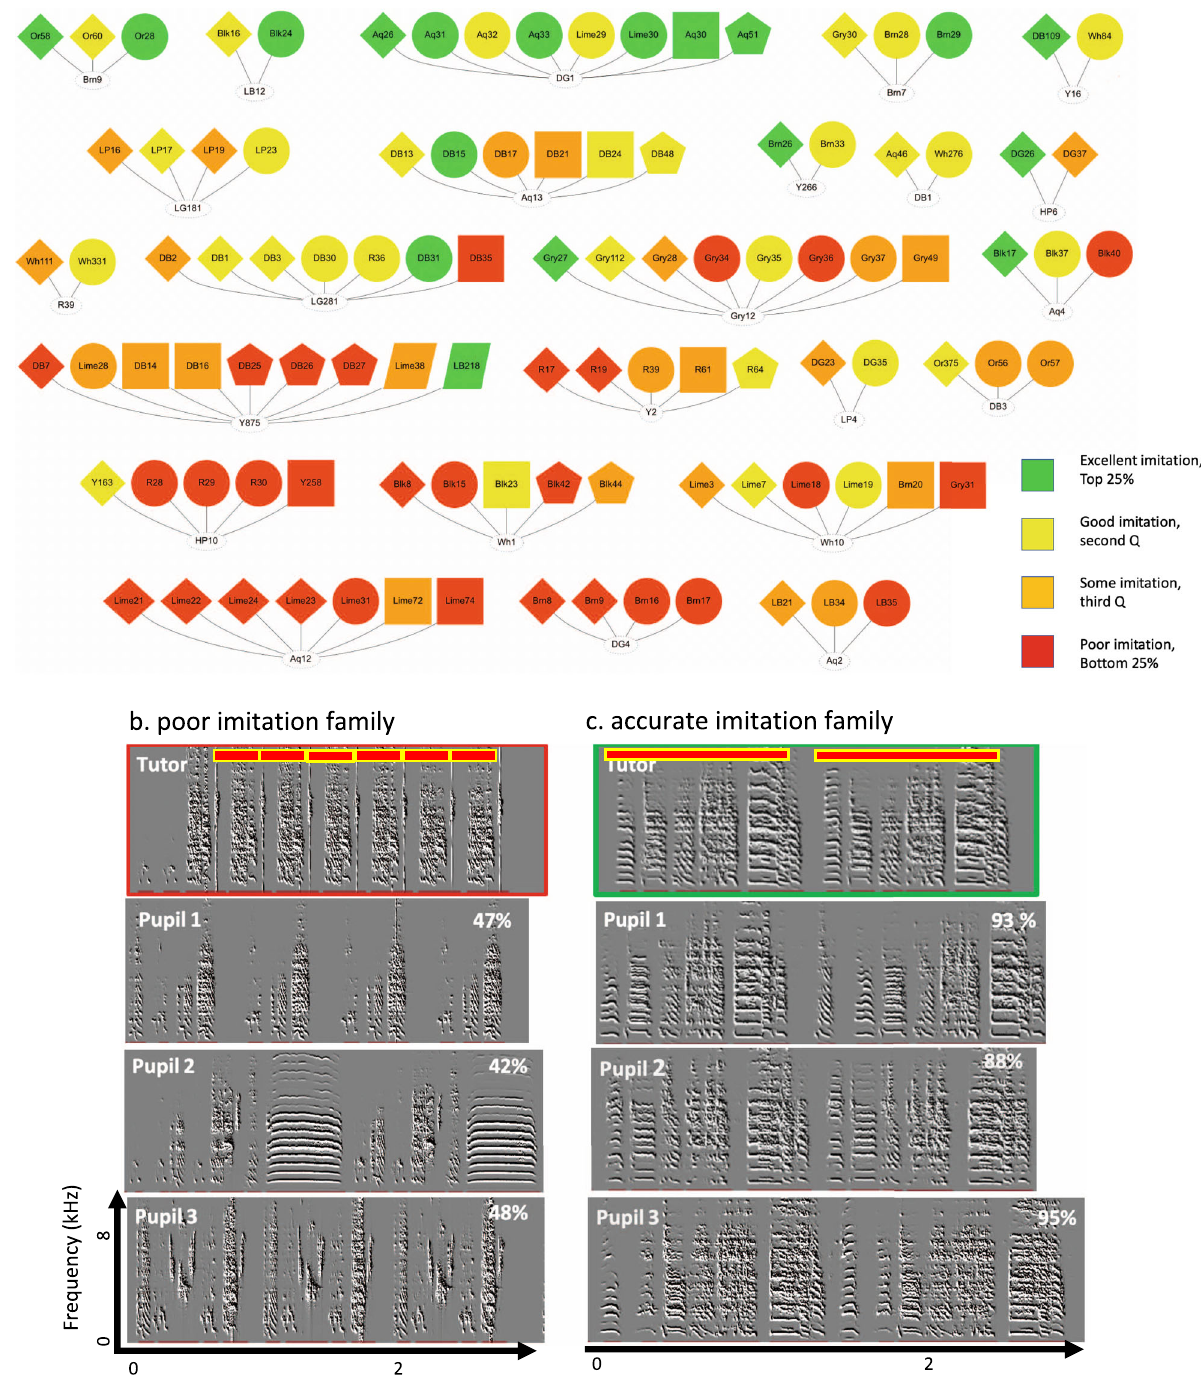
Fig. 2 Imitation outcome varies across families. a 24 song tutoring lineages. All tutors had pupils in more than a single clutch. Each node represents one individual animal. Node shape represents pupils from the same clutch. Tutor nodes are presented on the bottom and pupil nodes on the top. Similarity scores are presented as quartiles (green for best imitations and red for poorest). Lineages are sorted according to the mean similarity between tutor and pupils from highest (top) to lowest (bottom). b , c Examples of song imitations from tutor AQ12 with a low similarity family ( b ) and from tutor DG1 with a high similarity family ( c ). Imitation outcomes are presented as percent acoustic similarity estimates on each sonogram. Red bars outline the repeated song motifs of the tutors. Source data for this fi gure is in Supplementary Data File